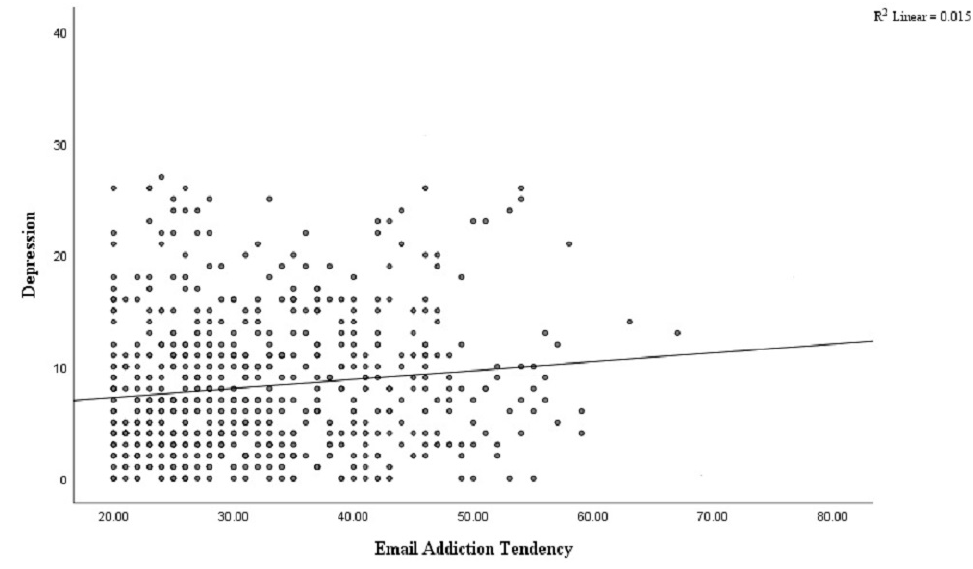
Figure 3. Associations between email dependence and abstract reasoning.